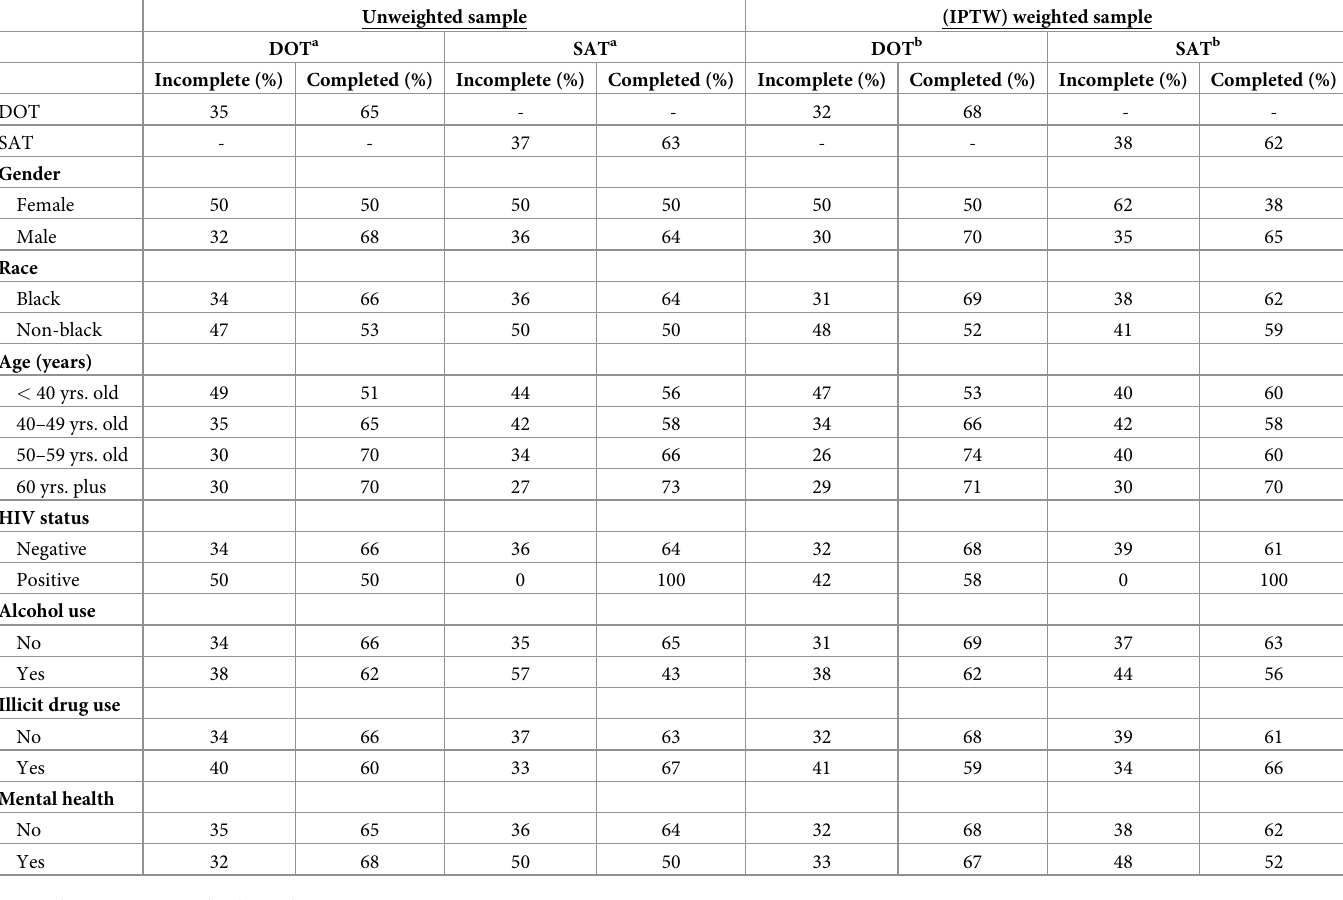
Table 3. Latent TB infection treatment completion in the unweighted and weighted samples of homeless persons treated with 4 months of daily rifampin in Fulton County, Georgia